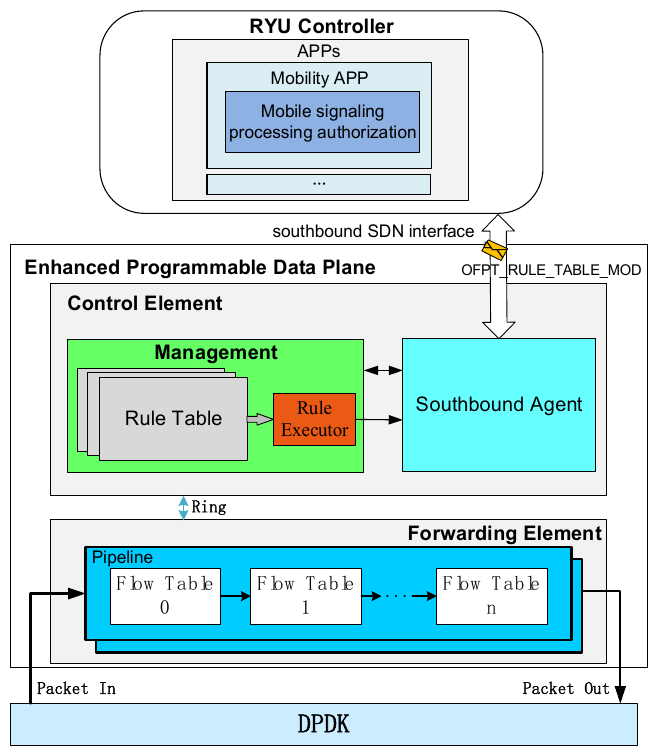
Figure 6. Implementation of the enhanced programmable data